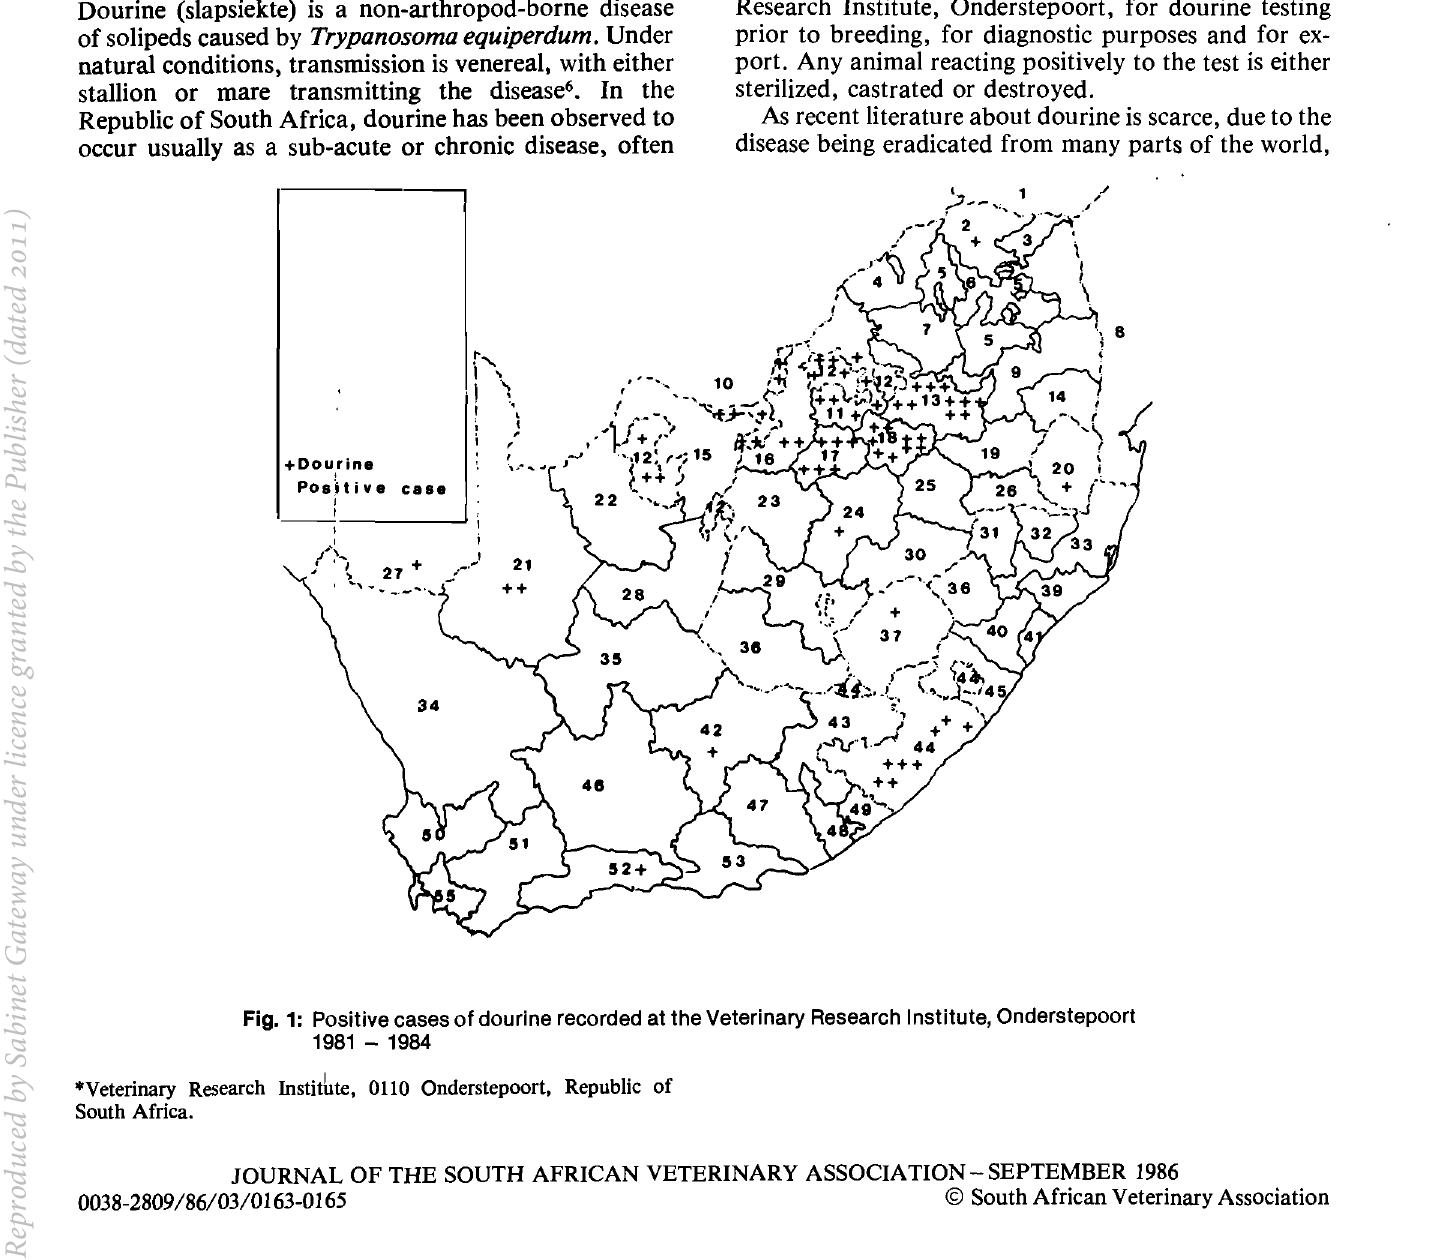
Fig. 1: Positive cases of dourine recorded at the Veterinary Research Institute, Onderstepoort 1981 - 1984 *Veterinary Research Instithte, 0110 Onderstepoort. Republic of South